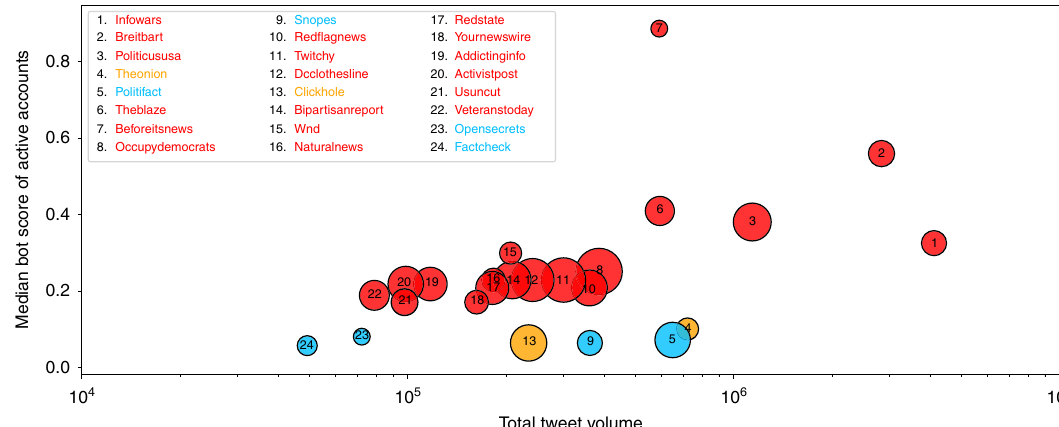
Fig. 6 Popularity and bot support for the top sources. Satire websites are shown in orange, fact-checking sites in blue, and low-credibility sources in red. Popularity is measured by total tweet volume (horizontal axis) and median number of tweets per article (circle area). Bot support is gauged by the median bot score of the 100 most active accounts posting links to articles from each source (vertical axis). Low-credibility sources have greater support by bots, as well as greater median and/or total volume in many